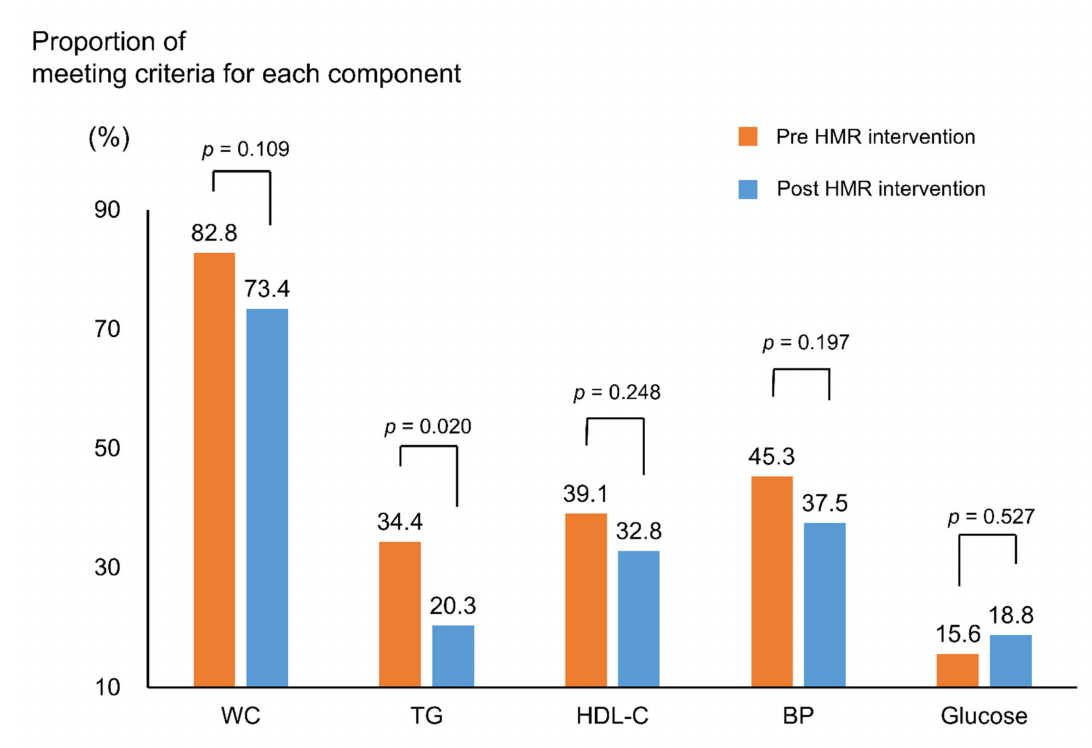
Figure 3. Proportion meeting criteria for each component of metabolic syndrome in intervention group. p -values were calculated using the McNemar test; criteria for each component: Central obesity (WC ≥ 90 cm in men and ≥ 85 cm in women), hyperglycemia (IFG ≥ 100 mg/dL), hypo-HDL-cholesterolemia (HDL-C < 40 mg/dL in men and < 50 mg/dL in women), hypertriglyceridemia (TG ≥ 150 mg/dL), and high BP (SBP ≥ 130 mmHG or DBP ≥ 85 mmHg); Abbreviations: HMR, home meal replacement; WC, waist circumference; TG, triglycerides; HDL-C, high-density lipoprotein cholesterol; BP, blood